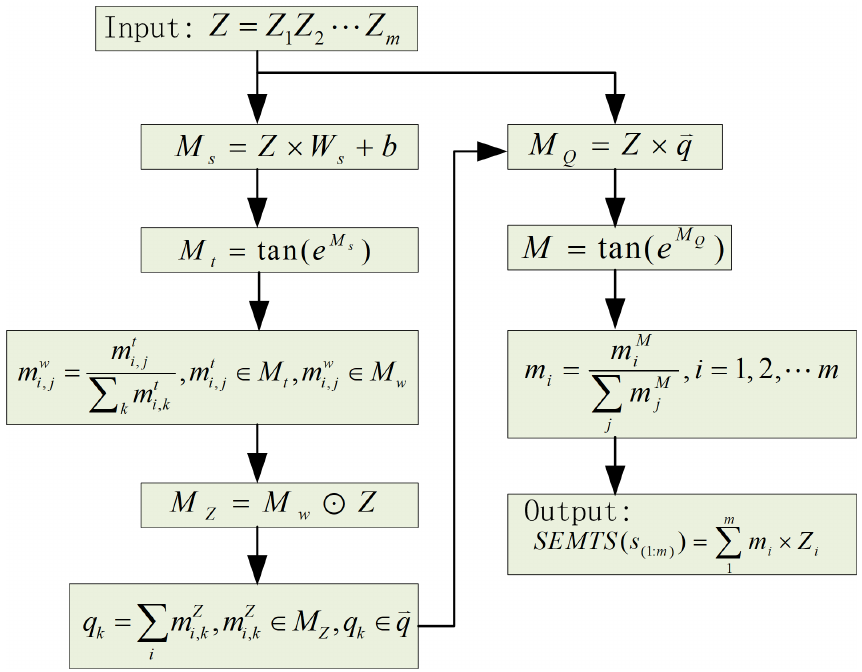
Figure 3. The calculation process of the sentence representation denoted by SEMTS ( s ( 1: m ) ) . In Figure 3, (cid:126) q , W s , and b represent the query vector, the shape transformation